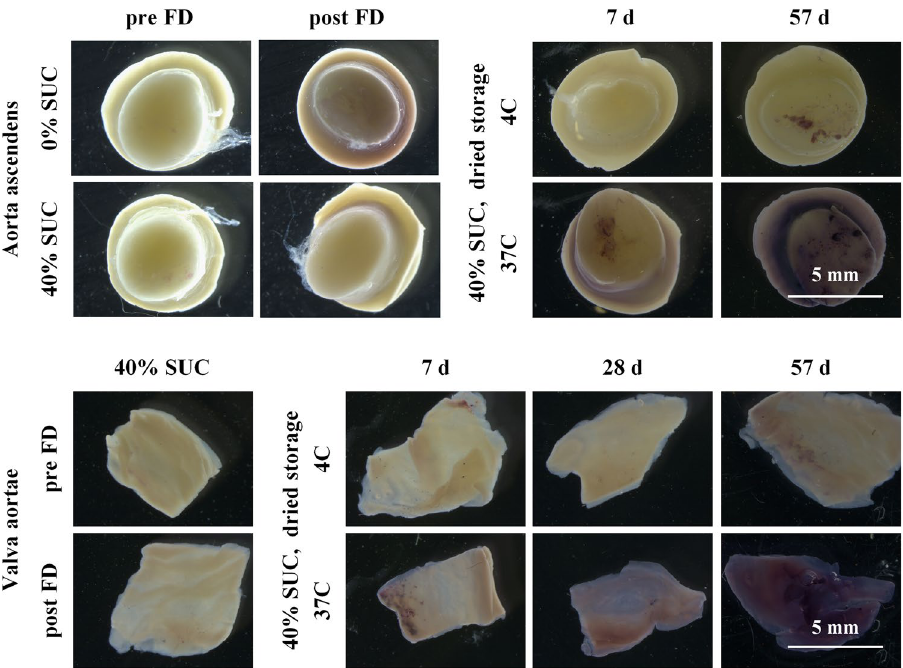
Figure 1. Visualization of accumulation of reactive oxygen species in decellularized and freeze-dried heart valve tissue, by means of NBT-formazan formation. Both artery and leaflet tissues were analyzed, before and after freeze-drying (FD) with 40% sucrose (SUC), and during dried storage at 4 °C and 37 °C for up to 2 months. Microscopic images were collected from fixed samples using similar acquisition settings. Blue/purple staining results from formazan formation, due to NBT reacting with reactive oxygen